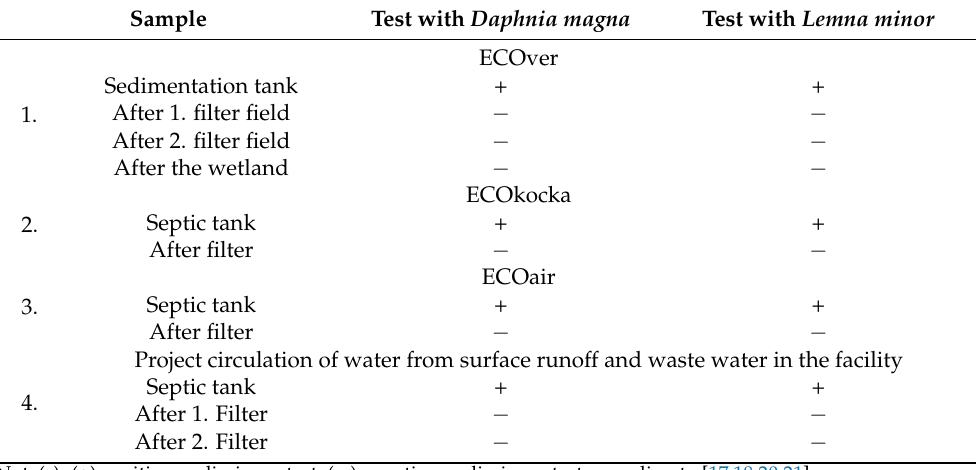
Table 7. Ecotoxicological assessment of the quality of treated waste water from selected root WWTPs and the water recirculation